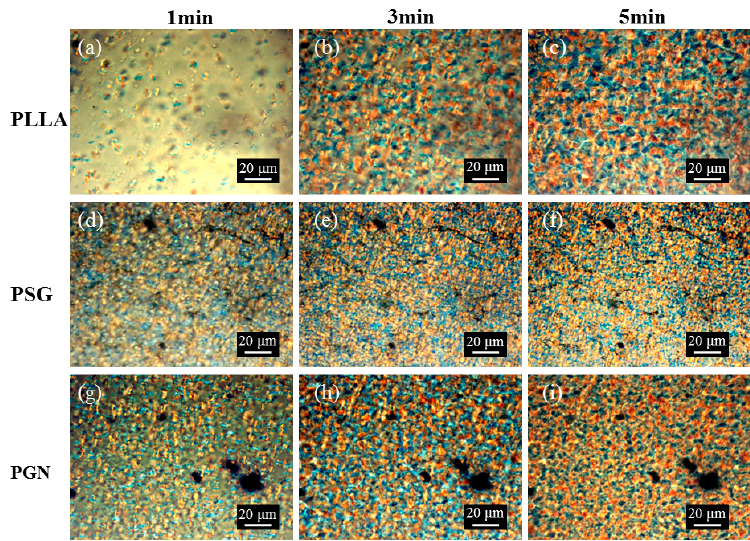
Figure 5. Polarized optical micrographs for 1 min, 3 min and 5 min of ( a – c ) neat PLLA isothermally crystallized at 120 ◦ C ( d – f ) PSG nanocomposite isothermally crystallized at 136 ◦ C ( g – i ) and PGN crystallized at 120 °C ( d – f ) PSG nanocomposite isothermally crystallized at 136 °C ( g – i ) and PGN nanocomposite isothermally crystallized at 127 °C. nanocomposite isothermally crystallized at 127 ◦